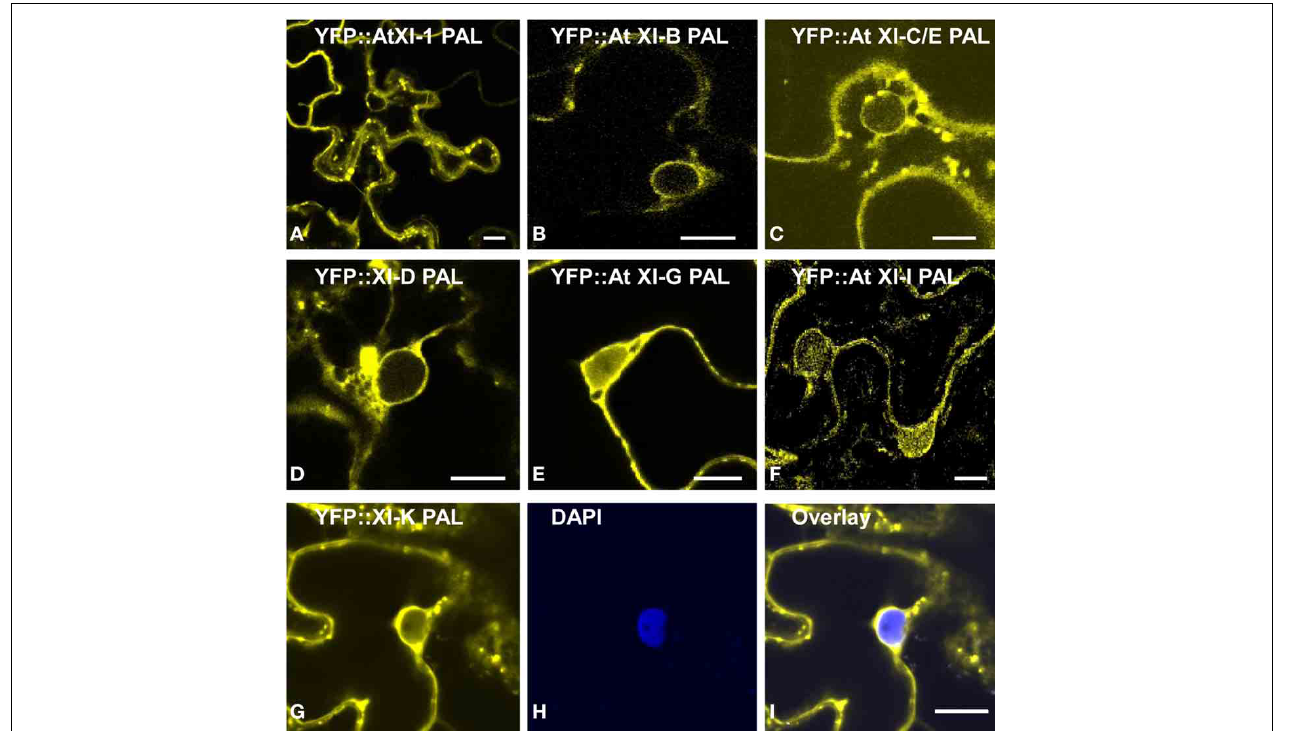
FIGURE 6 | Transient expression of YFP fusions of A. thalian a class XI myosin PAL sub-domains in epidermal leaf cells of N. benthamiana . YFP fusionsofAtXI-1PAL (A) ,AtXI-BPAL (B) ,AtXI-C/EPAL (C) ,AtXI-DPAL (D) ,At